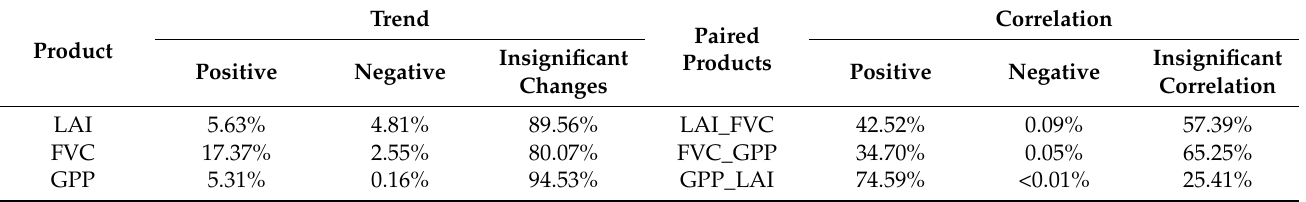
Table 3. Statistical results on the correlations and trends of LAI, FVC, and GPP products during 2000–2018 ( α =